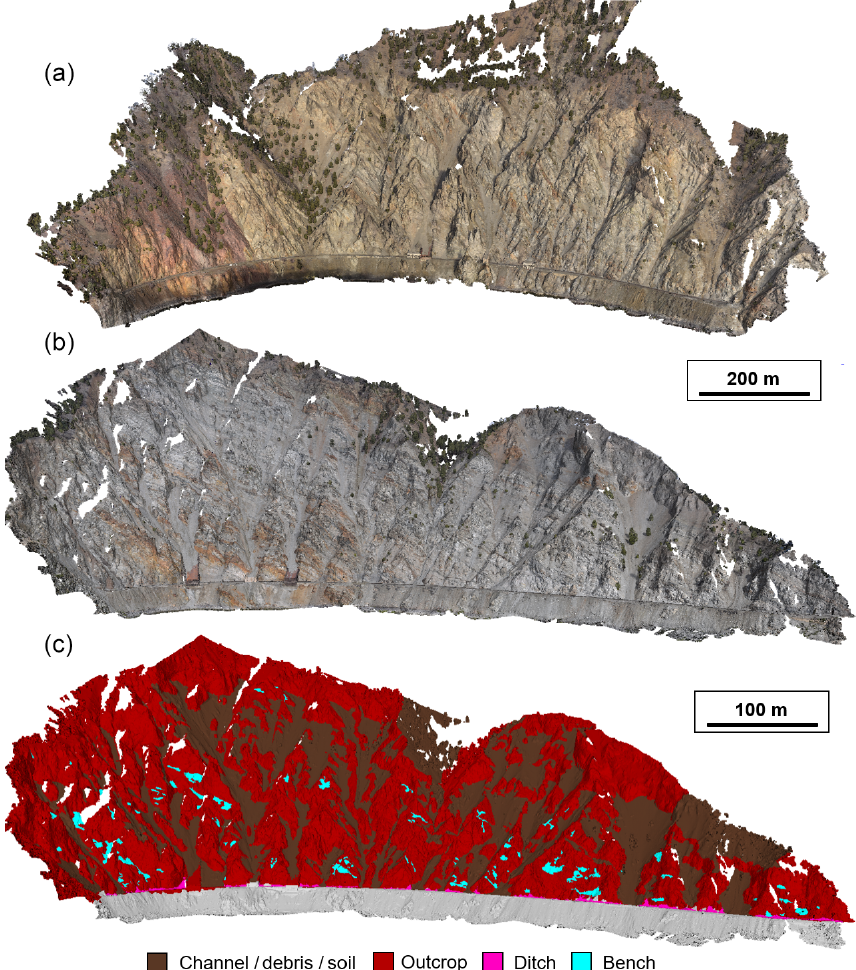
Figure 4. Overview of the SfM-MVS photogrammetry models. (a) Model of White Canyon West (WCW) taken on 30 January 2017. (b) Model of White Canyon East (WCE) taken on 4 April 2017. (c) Classified model of WCE. The model was remotely mapped in PhotoScan using a combination of the RGB point cloud and visual inspection of the panoramic